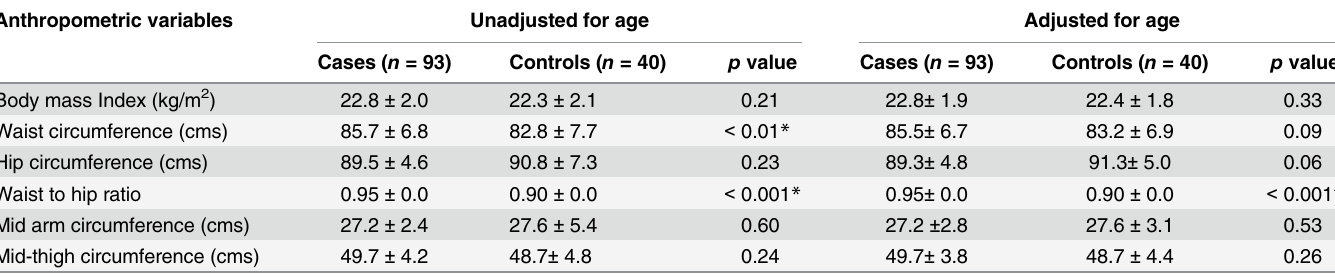
Table 1. Anthropometric